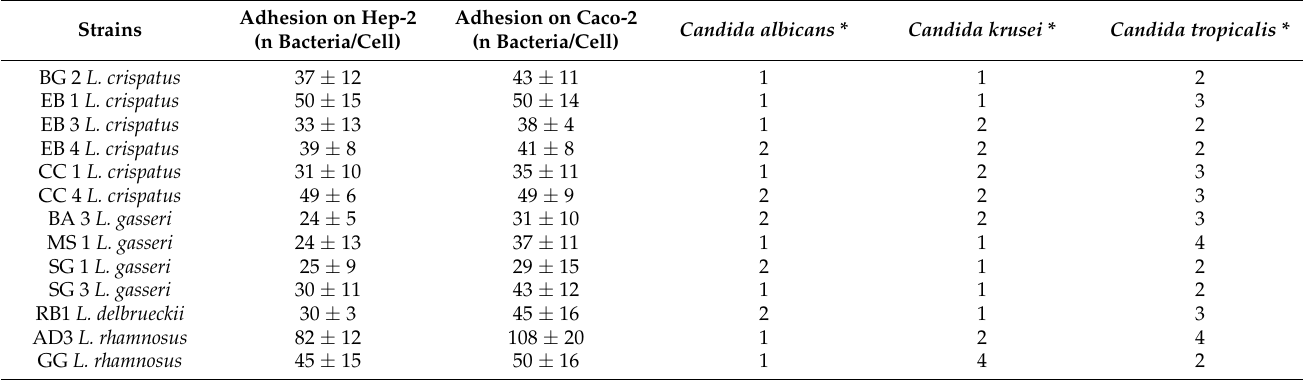
Table 3. Adhesion of Lactobacillus strains to Hep ‐ 2 cells and Caco ‐ 2 [29] and co ‐ aggregation rates obtained with three different strains of Candida [31].